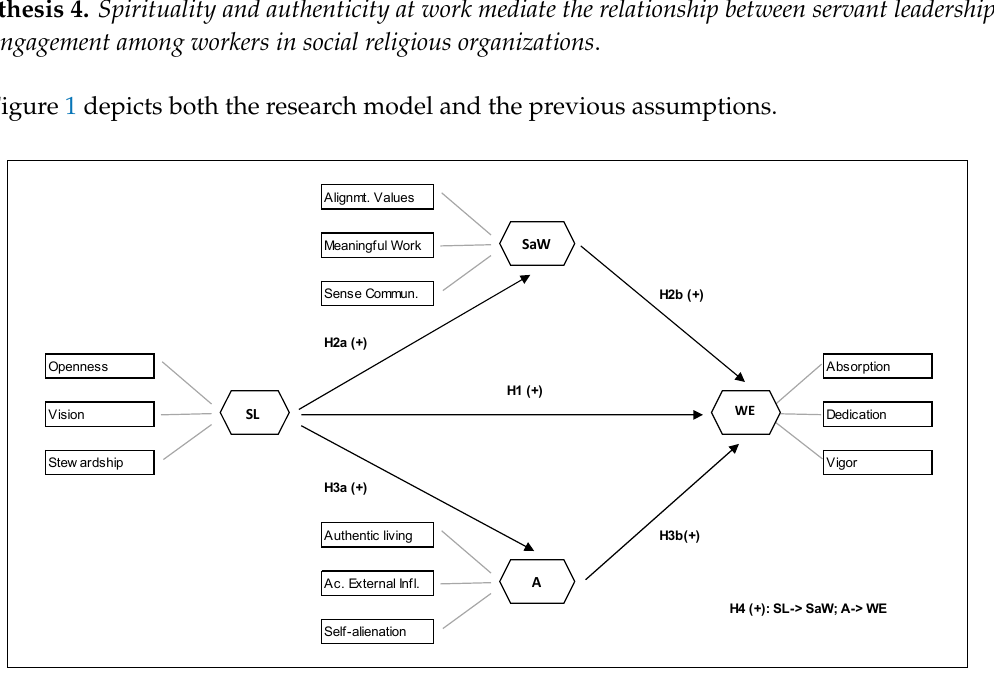
Figure 1. Research model and hypothesis; A, authenticity; SaW, spirituality at work; SL, servant leadership; WE, work engagement.